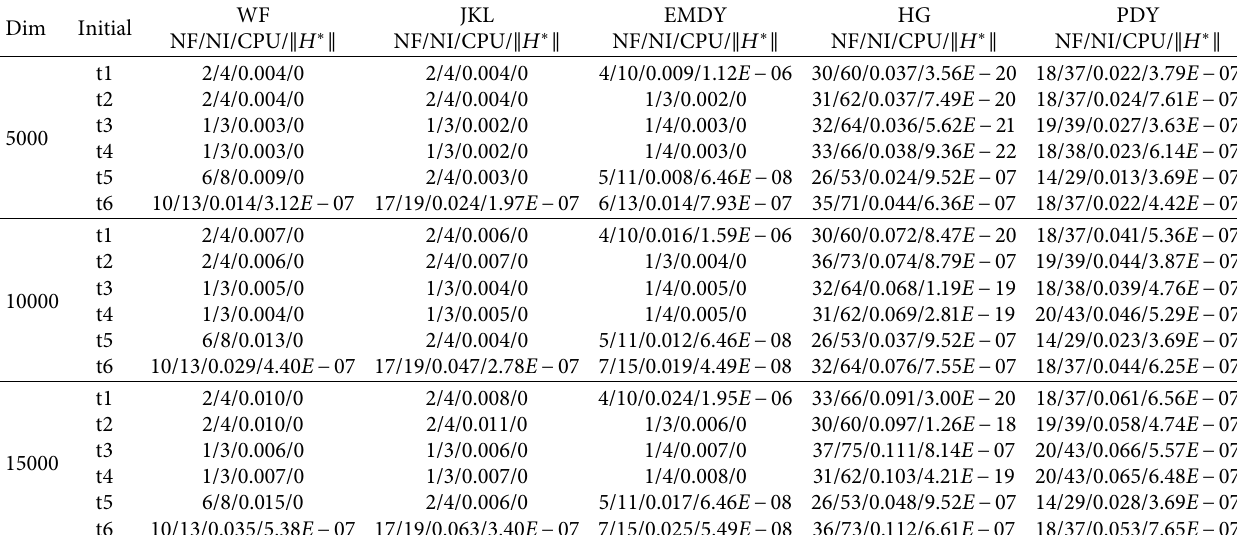
Table 2: Numerical results on problem